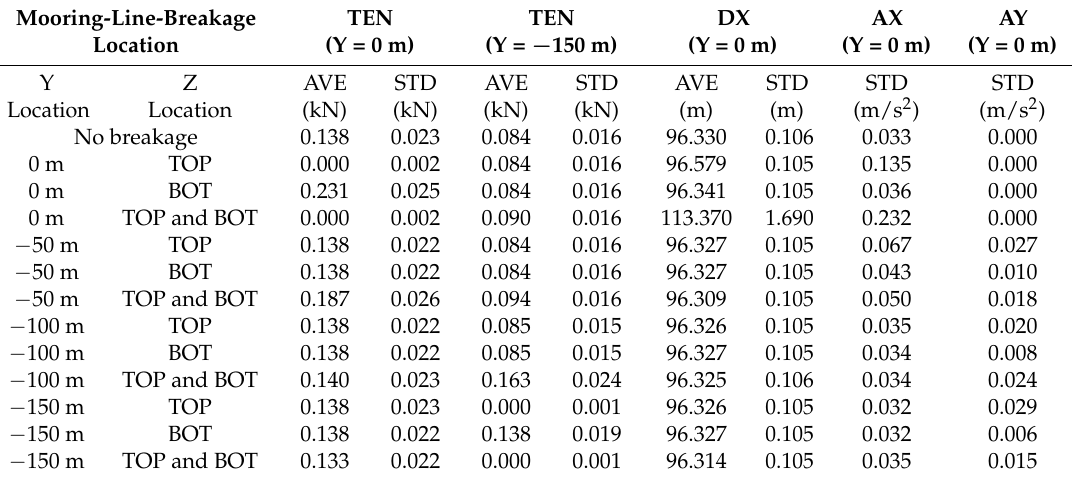
Table 4. Statistical data of mooring tension, surge motion of the location buoy, and acceleration of the net assembly in the X and Y directions in different mooring-line-breakage scenarios at H s = 1.0 m, T p = 6.0 s, and current velocity = 0.6 m/s (AVE = average value and STD = standard deviation).